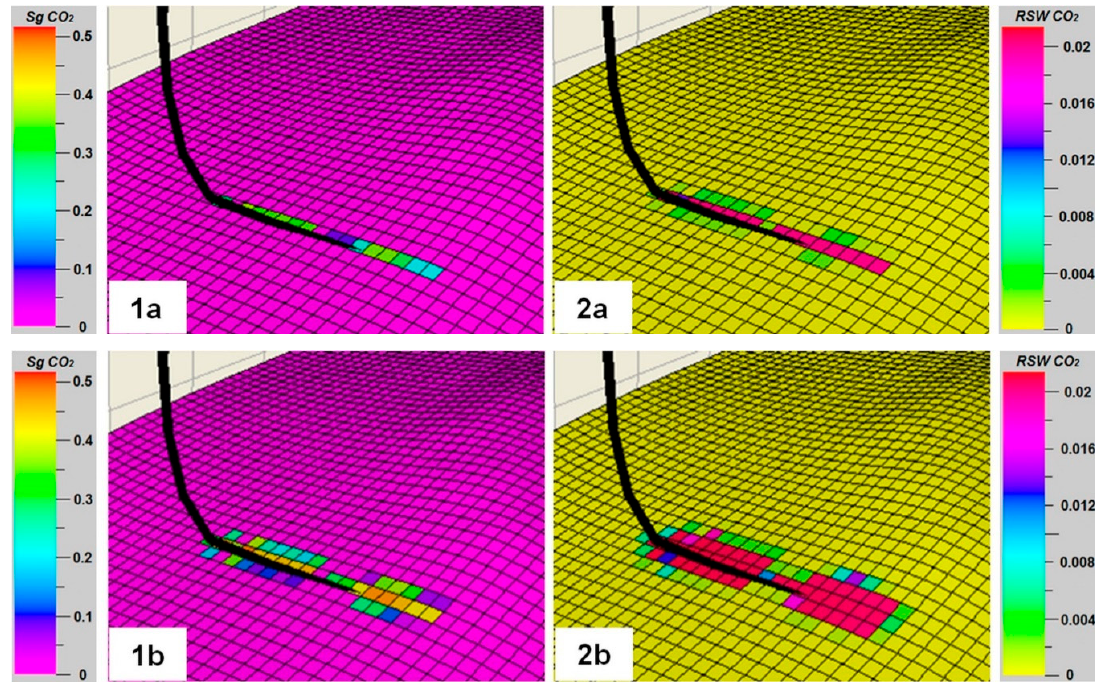
Figure 17. Aquifer influx flowrates in an analytical aquifer ( a ) and process of free phase reduction of carbon dioxide, due to the dissolution of CO 2 in brine ( b ) in simulation variant